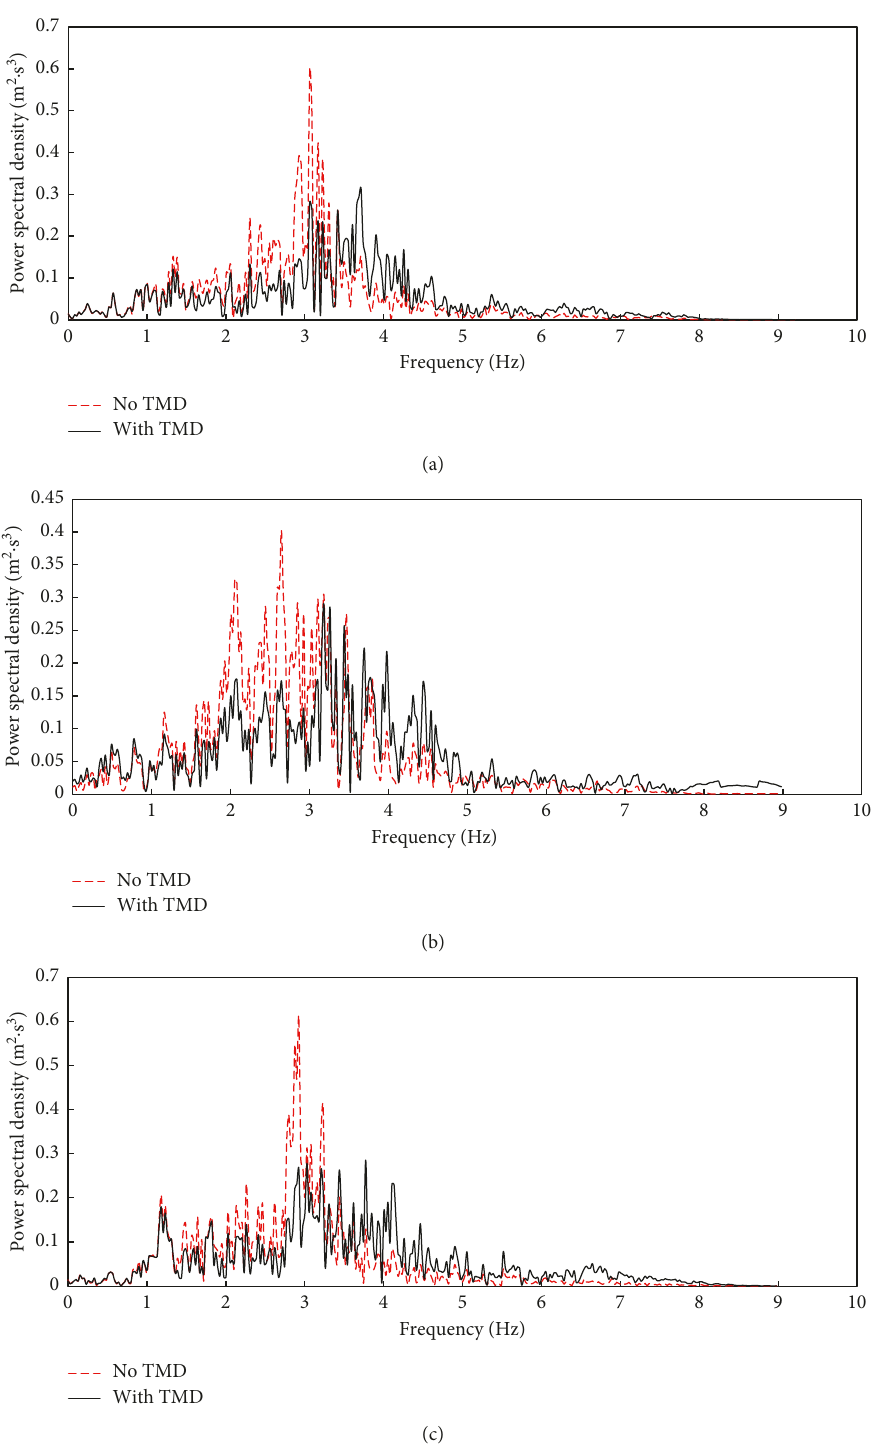
Figure 15: Power spectral density of the acceleration under earthquake-induced seismic wave excitation. Power spectral density of the acceleration for the (a) El-Centro NS seismic wave, (b) Taft EW seismic wave, and (c) Fukushima NS seismic